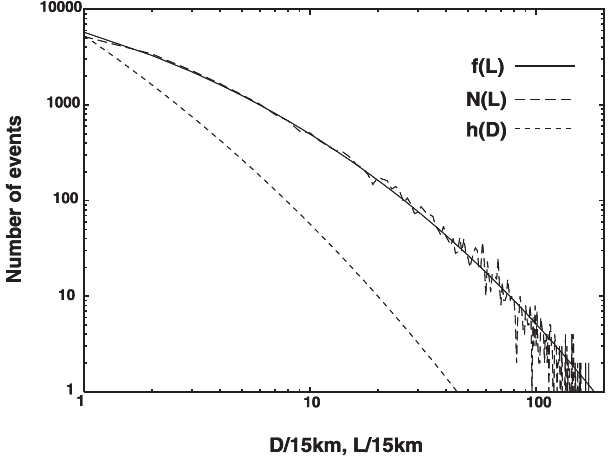
Fig. 4. As Fig. 3, but with the parameters: a (cid:136) 0 : 0000012, N